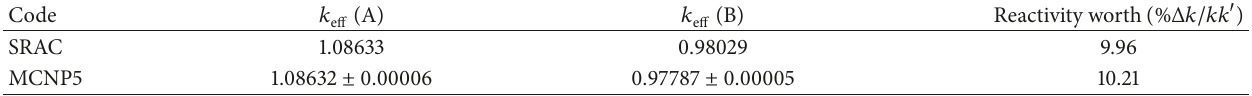
Figure 5: Vertical and horizontal cross sections of the DNRR in the MCNP5 model. Table 2: The 𝑘 eff in the cases of complete withdrawal and full insertion of control